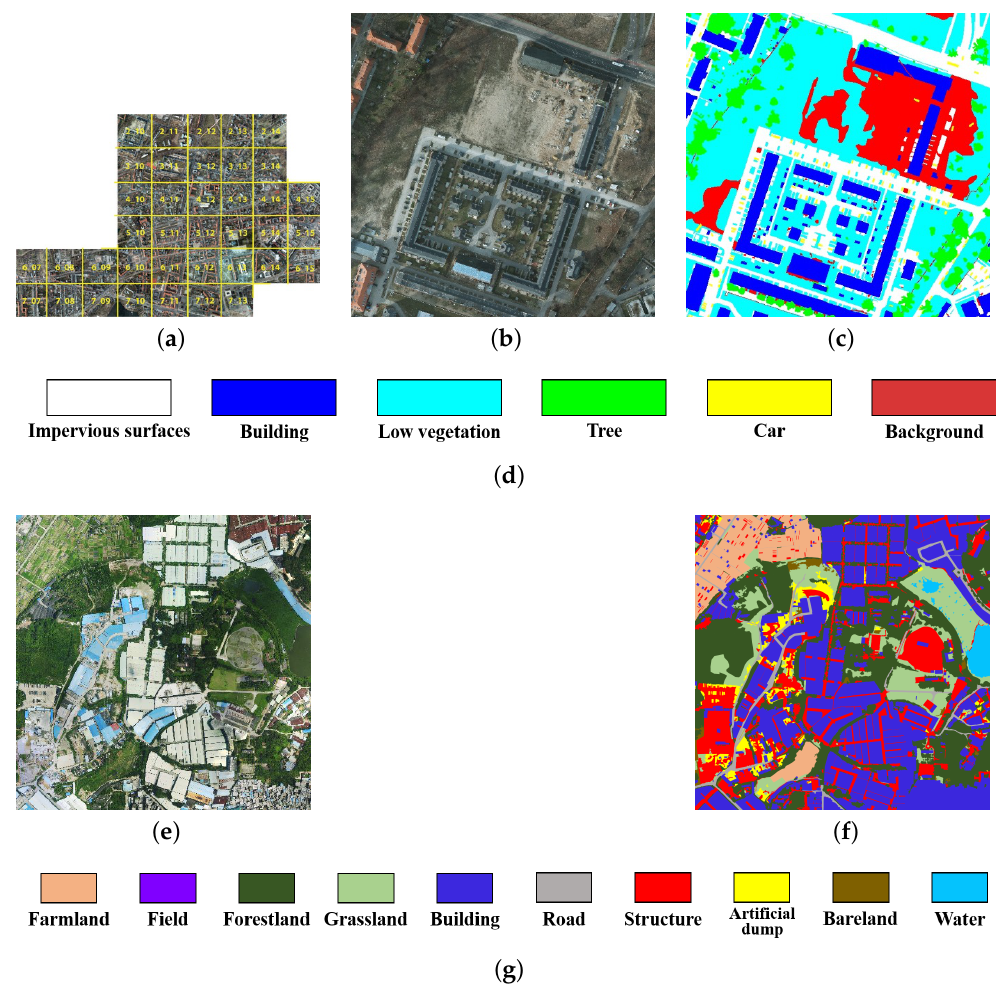
Figure 11. Example image, corresponding label and legend of two public datasets, the ISPRS Potsdam dataset and Evlab dataset. ( a ) the Potsdam dataset; ( b ) one image in Potsdam dataset; ( c ) corresponding ground truth; ( d ) legend of Potsdam dataset; ( e ) one image in Evlab dataset; ( f ) corresponding ground truth; ( g ) legend of Evlab